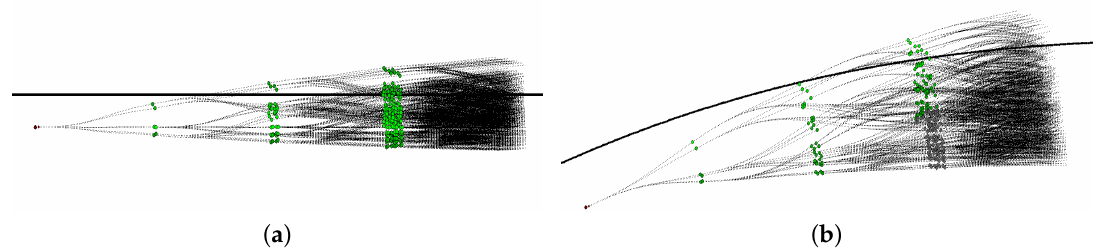
Figure 9. Real paths and real expansion trees (logically described in Figure 3) for a straight path ( a ) and a curved path ( b ). The car is initially placed at the center of the lane and its target is to converge on the specified path (black line). To have an idea of the convergence speed, the lane is 6 m wide and the trajectory about 40 m